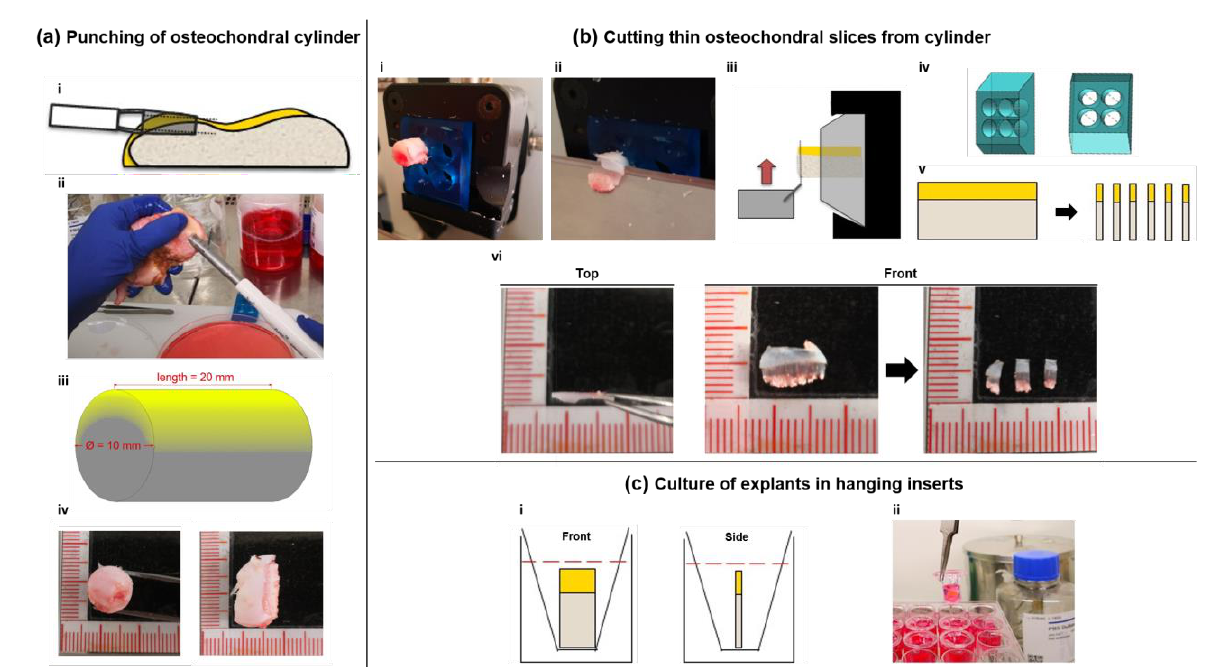
Figure 4. Fabrication and culture of osteochondral live slices. ( a ) Punching of Osteochondral cylinders. A 2 × 1 × 1 cm long osteochondral cylinder is punched out of the macroscopically unaffected area of a recently explanted human tibial plateau under sterile conditions using an orthopedic OATS ® Tissue Punch (i,ii). The resulting cylinder is shown schematically in iii, cartilaginous areas are highlighted in yellow. Front and side views of the cylinder are shown in iv. ( b ) Cutting of osteochondral slices from cylinder. The cylinder is inserted into a 3D-printed microtome insert (iv) with no additional fixation (i), and 500–800 µm thick cuts are cut out from the cylinder (ii). Fixation of the cylinder is shown schematically in iii. The resulting disc-shaped cuts (schematic: v) are cut into three parallelepipedal slices using a scalpel (vi). ( c ) Slices are immediately transferred to a hanging insert of a multi-well plate and covered in cell culture medium (i,ii). Plates are then placed on a horizontal shaker for culture at 37 °C and 5% CO 2 .